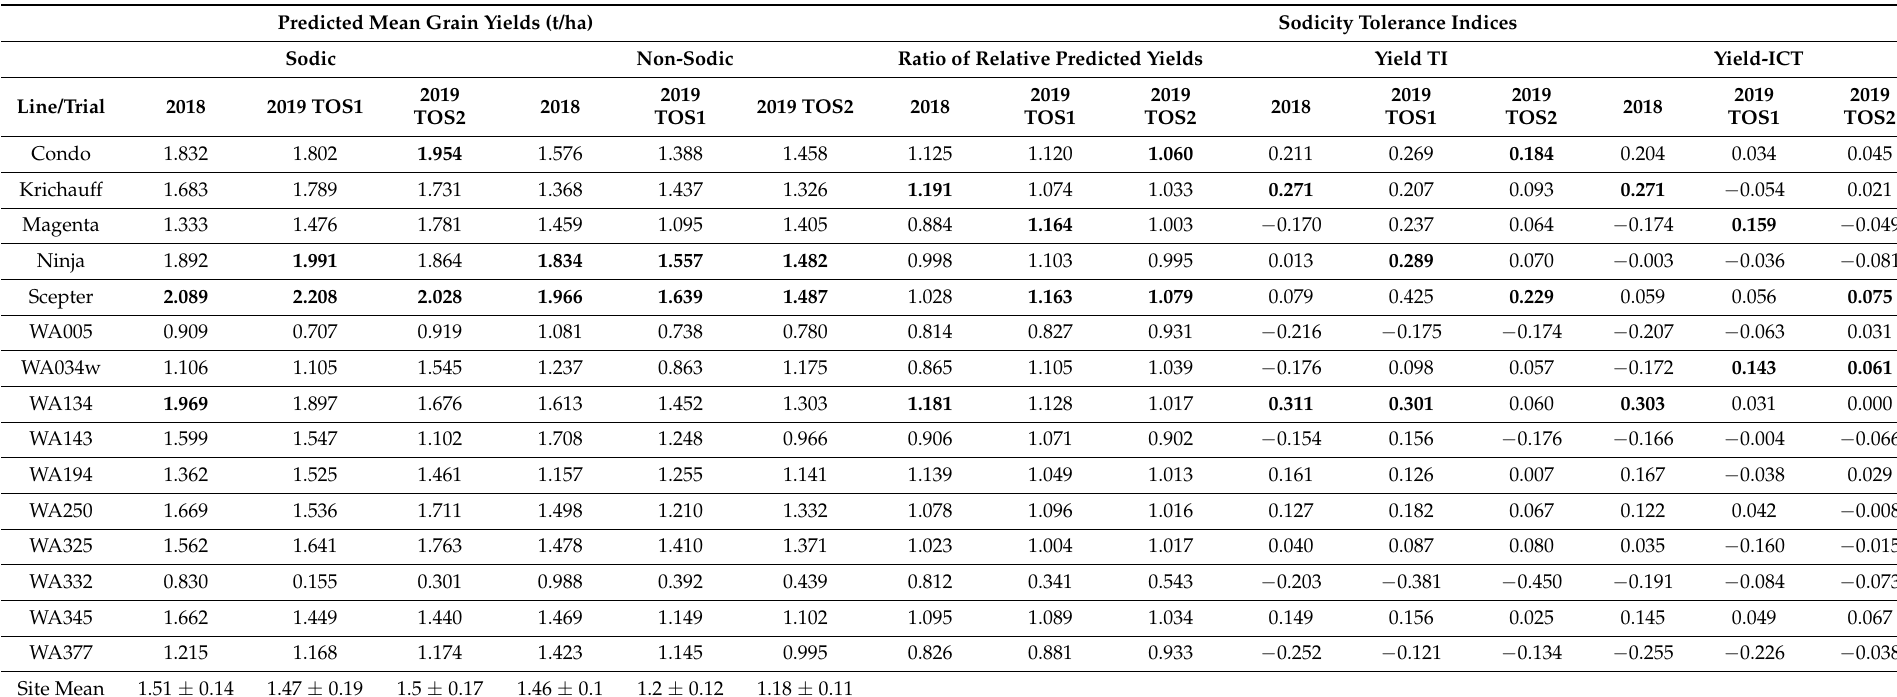
Table 2. Predicted mean grain yields (t/ha) and sodicity tolerance analyses based on Ratio of relative predicted grain yields, Yield Tolerance Index (TI), and Yield Incremental Crop Tolerance (Yield-ICT). Data are for 15 wheat lines screened in 2018 and 2019; in 2019 at two times of sowing (TOS1 and TOS2). The ratio of relative predicted yields is calculated by the line yield/site mean yield for each site (see Methods). Bold text represents the top two highest values in each column. Predicted Mean Grain Yields (t/ha) Sodic Ratio of Relative Predicted Yields Yield